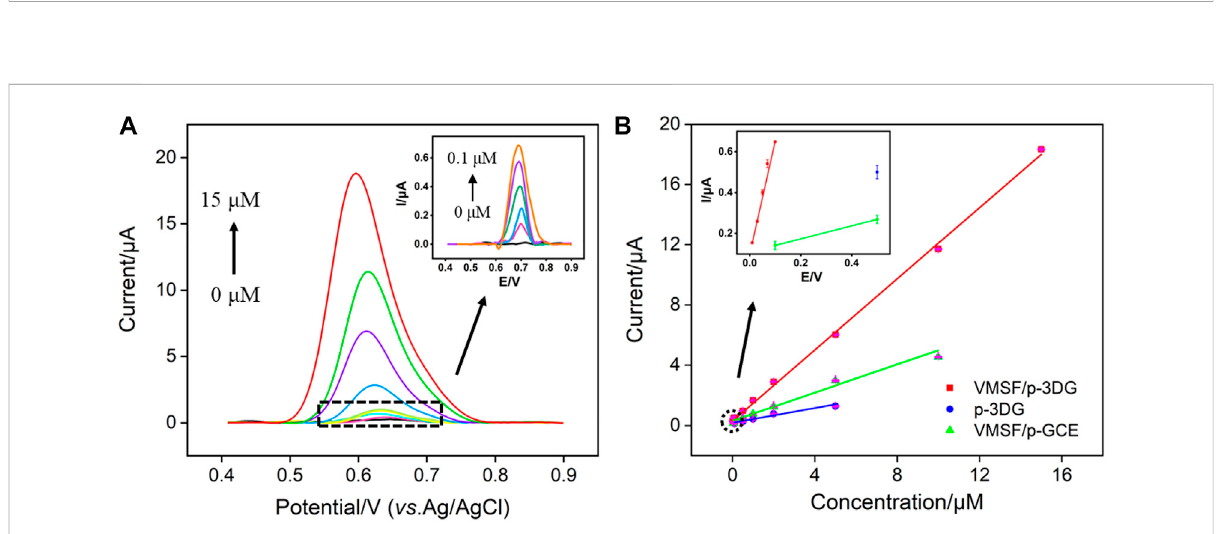
FIGURE 7 (A) DPV curves obtained on VMSF/p-3DG electrode at different concentration of TCP. Inset is the magni fi edview of the DPV curvesin the low- concentration region. (B) The calibration curve for detection of TCP using different electrodes. Inset is the magni fi ed view in the low-concentration